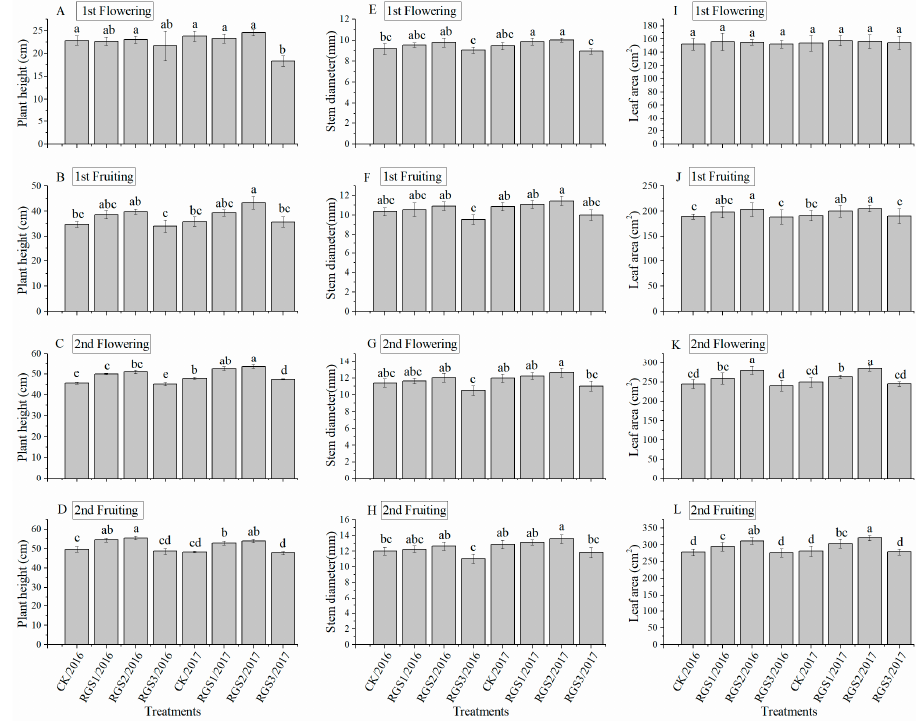
Figure 1. Effect of amendment with raw garlic stalk on various growth and development parameters of eggplant recorded at different growth stage of eggplant. Plant height ( A ) 1st flowering, ( B ) 1st fruiting, ( C ) 2nd flowering and ( D ) 2nd fruiting, stem diameter ( E ) 1st flowering, ( F ) 1st fruiting, ( G ) 2nd flowering and ( H ) 2nd fruiting, leaf area ( I ) 1st flowering, ( J ) 1st fruiting, ( K ) 2nd flowering and ( L ) 2nd fruiting. The error bars represent standard error of the means ( n = 3). Different letters between treatments at different sampling stages show significant difference at p < 0.05 level (ANOVA and LSD).